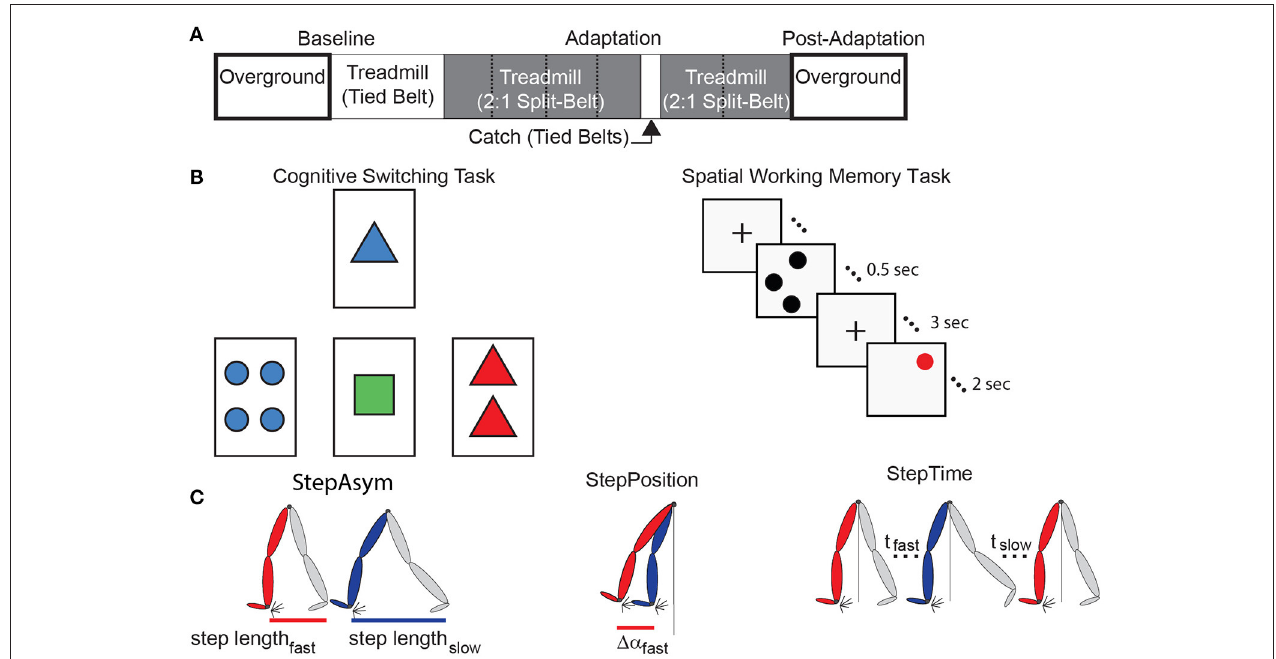
FIGURE 1 | Experimental paradigms and parameter definitions. (A) The split-belt treadmill paradigm used for both age groups is illustrated. Resting breaks, when subjects did not walk, are indicated by dashed lines. These were taken every 150 strides and lasted 8min and 10s on average. (B) The left panel is a sample screen for the card matching test to assess cognitive perseveration. The right panel demonstrates the temporal progression of a single trial of the computer-based test to assess spatial working memory accuracy. (C) This schematic adapted from Finley et al. (2015) illustrates Step Length Asymmetry (StepAsym) which can be decomposed into gait aspects that are controlled more explicitly (StepPosition) or implicitly